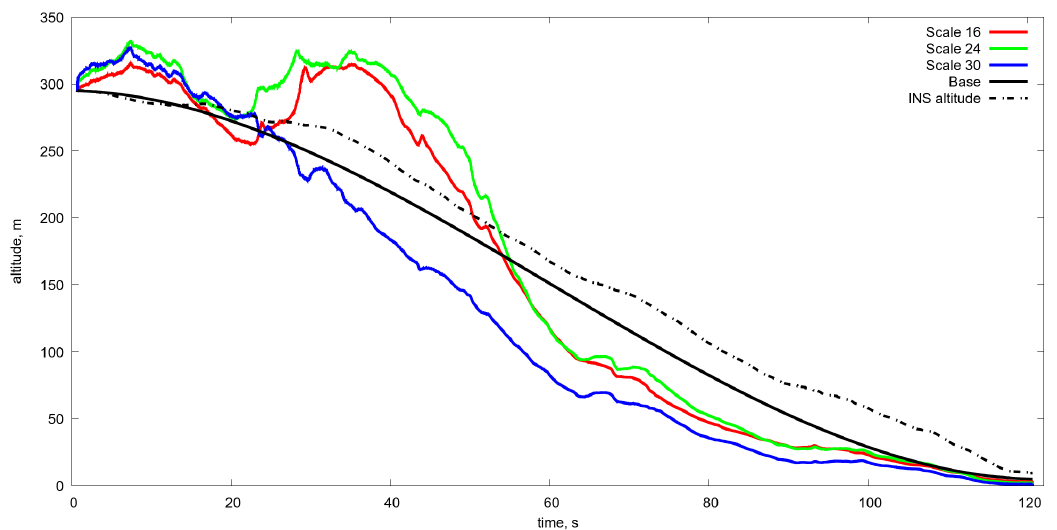
Figure 10. Estimated altitude in comparison with the real one obtained with a various level of resolution with averaging from 16 × 16 to 30 × 30. One can see that the averaging greater than 16 × 16 gives the acceptable accuracy of the altitude estimation in the range from 50 m to 5 m. Scale 16, 24, 30 estimated altitude obtained by optical flow and Kalman filtering with different level of averaging, namely from 16 to 30. Base is the program motion. INS is the altitude from the inertial navigation system.